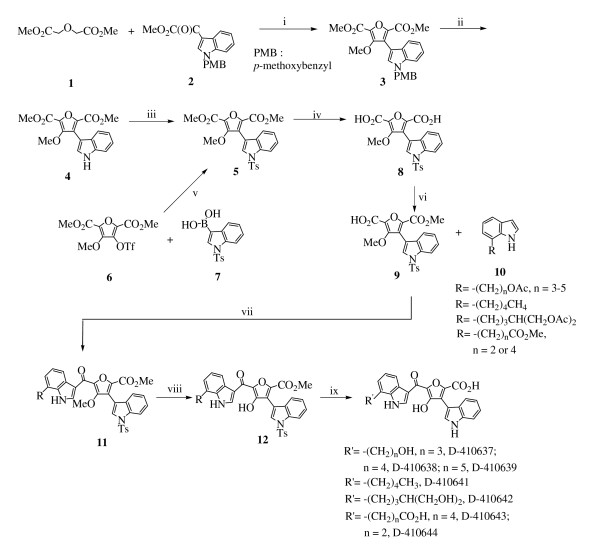
Preparation of bisindolylhydroxyfuroic acids. i. a) K, t-BuOH, benzene; b) MeI, N,N-dimethylformamide (DMF), 45% (two steps); ii. DDQ, CH2Cl2/H2O (18/1, v/v); 46%; iii. TsCl, 2-butanone, K2CO3, reflux, 86%; iv. OH-, MeOH, H2O, 95%; v. PdCl2 (PPh3)2 (0.1 eq), Na2CO3 (3.0 eq), DMF, 90°C, 12 h, 66%; vi. ClCO2Me (100 mol %), NEt3 (107 mol %), CH2Cl2 (6 mL/mmol 8), DMAP (12 mol %), 60%; vii. a) oxalyl chloride, DMAP (cat.), r.t.; b) 7-substituted indole 10, Et2AlCl, CHCl3, 51-66%; viii. BCl3, CH2Cl2,0°C - r.t.; 80-85%; ix. 5% NaOH in methanol, reflux, 66-70%.